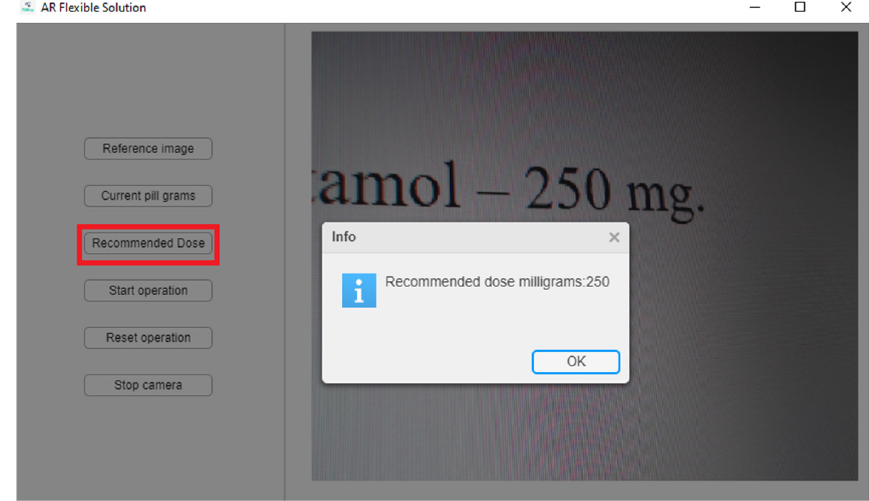
Figure 7. Identification of the dose weight.